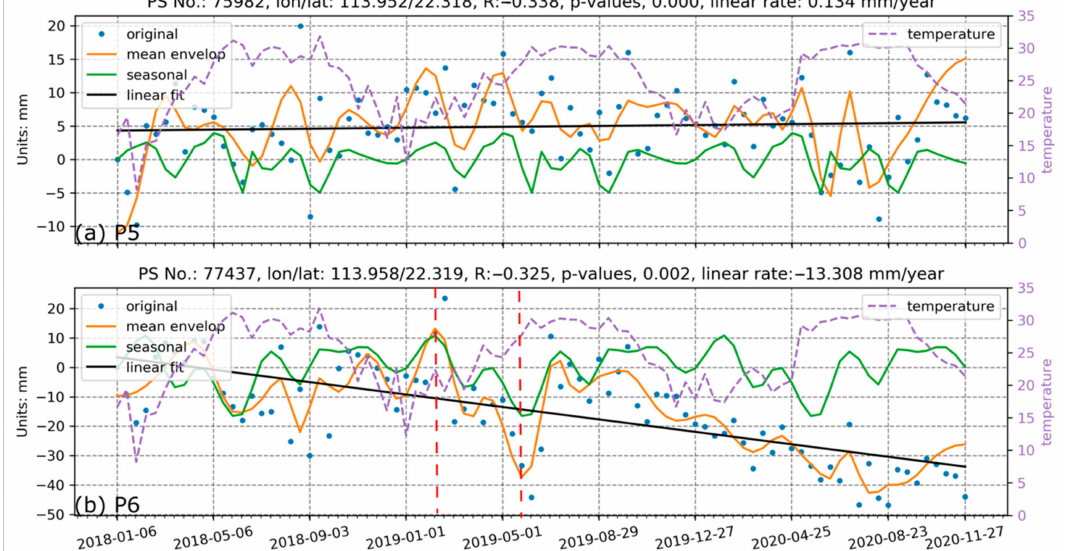
Figure 11. Time-series processing results of ( a ) P5 and ( b ) P6 on the Hong Kong Passenger Terminal. The red dashed lines indicate a period of a large